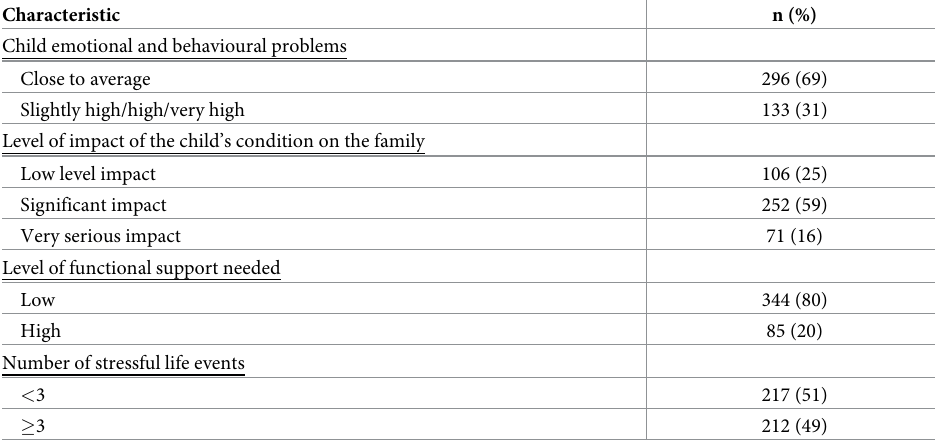
Table 2. Prevalence of child and family psychosocial characteristics (N =